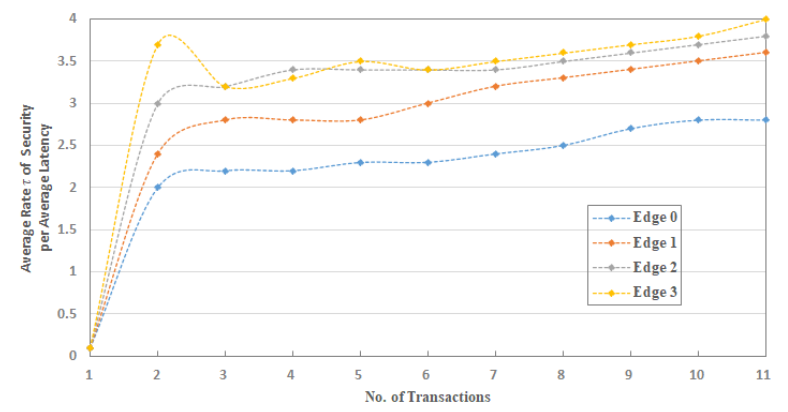
Figure 8. Average rate 𝜏 of security.